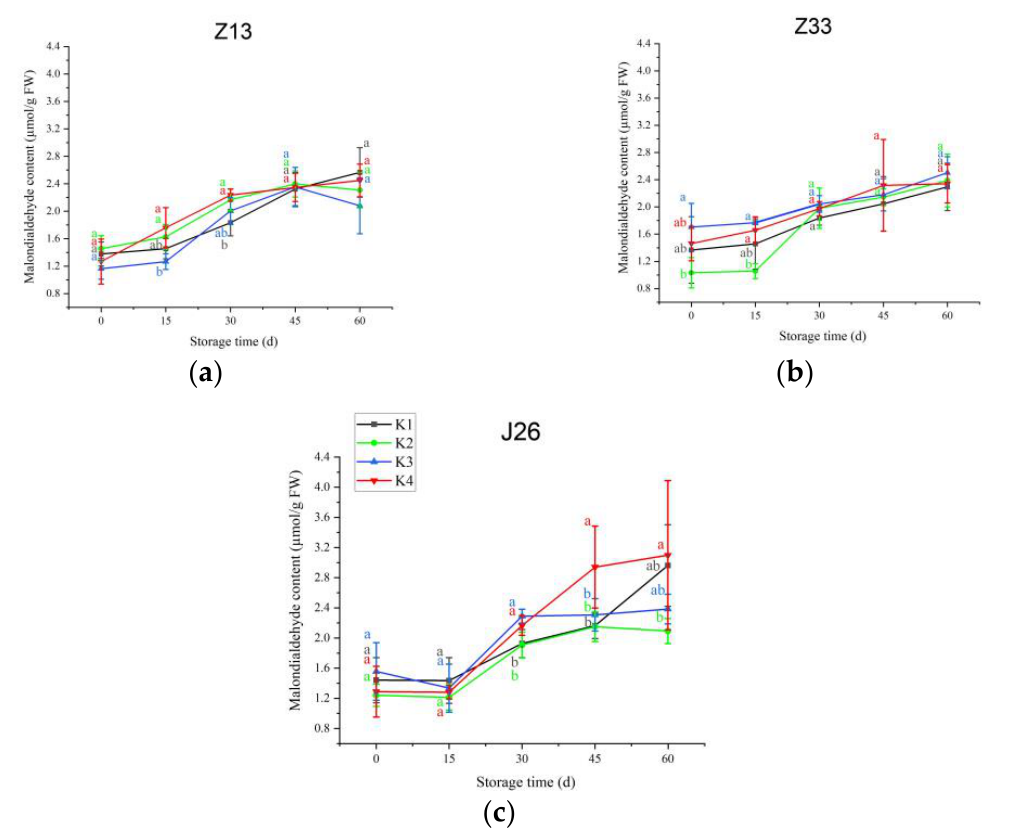
Figure 8. Malondialdehyde (MDA) content of the tuberous root of different UCZ treatments during storage. ( a ) Z13; ( b ) Z33; ( c ) J26. Values within the same storage day followed by the same letter are not significantly different at the 5% level according to ANOVA- Duncan’s multiple range test. K1: Normal basal fertilizing without UCZ; K2: Normal basal fertilizing with UCZ; K3: Rich basal fertilizing without UCZ; K4: Rich basal fertilizing with UCZ.